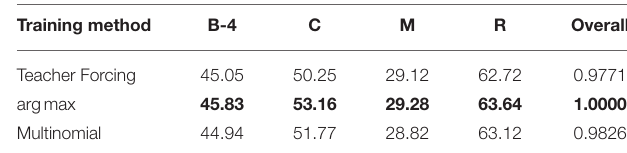
TABLE 6 | Results of different training strategies on MSR-VTT data with the best semantic features.